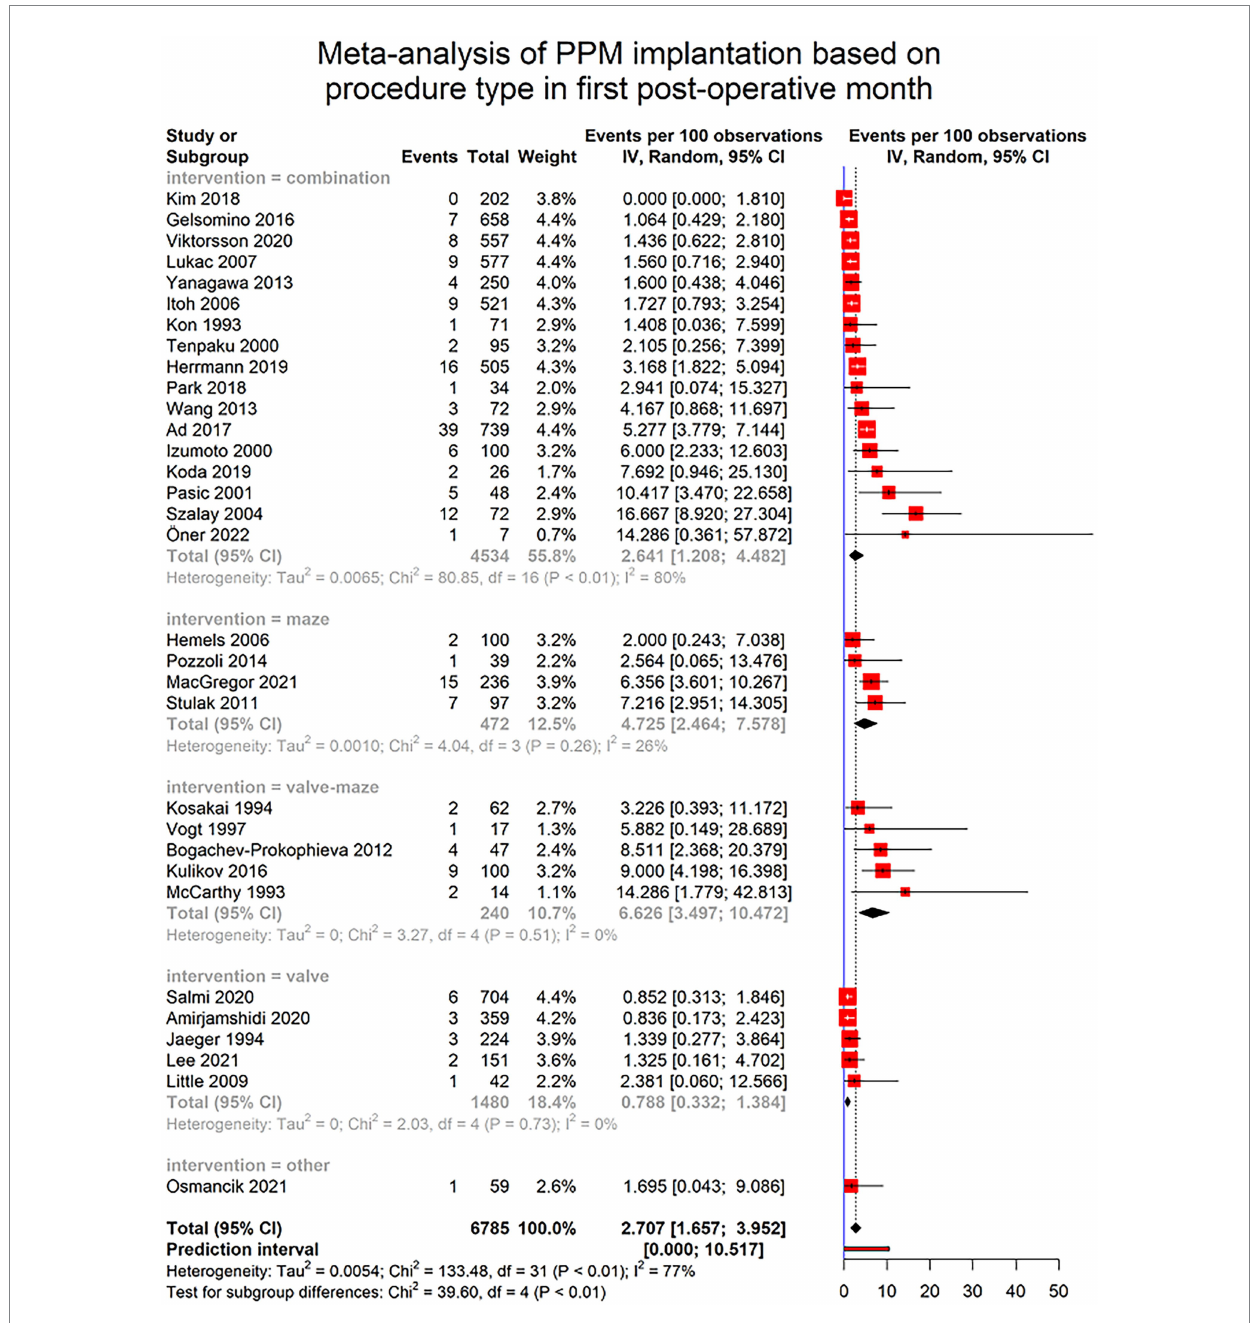
FIGURE 5 Forest plot showing pooled estimates of permanent pacemaker (PPM) implantation incidence in patients undergoing cardiac surgeries in the first month after surgery using random effects model (REM). Studies have been further divided into subgroups based on the type of the